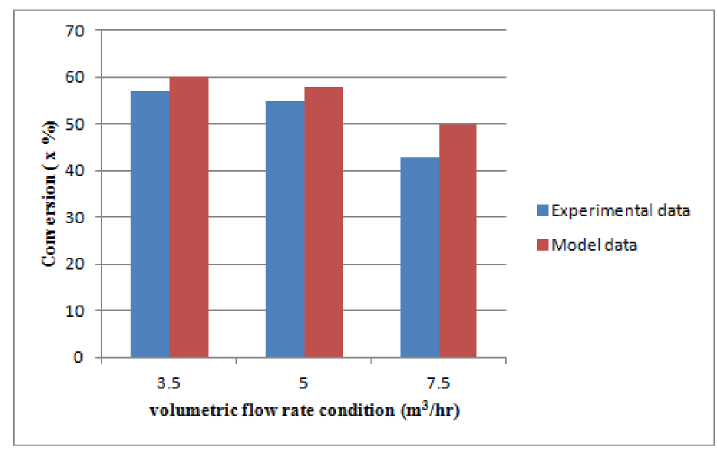
Figure 8. CO Conversion at base and change load condition based on experimental and model data.